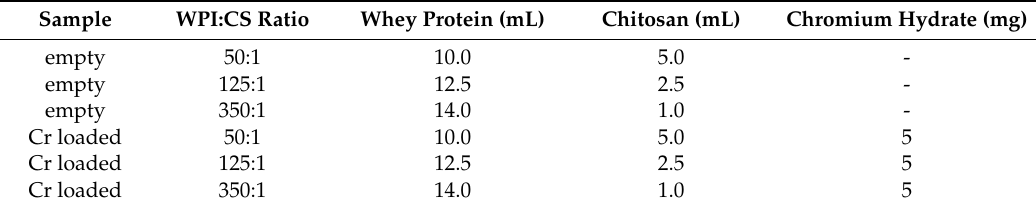
Table 2. Composition of empty and chromium-loaded whey protein isolate (WPI)-CS nanoparticle formulations.